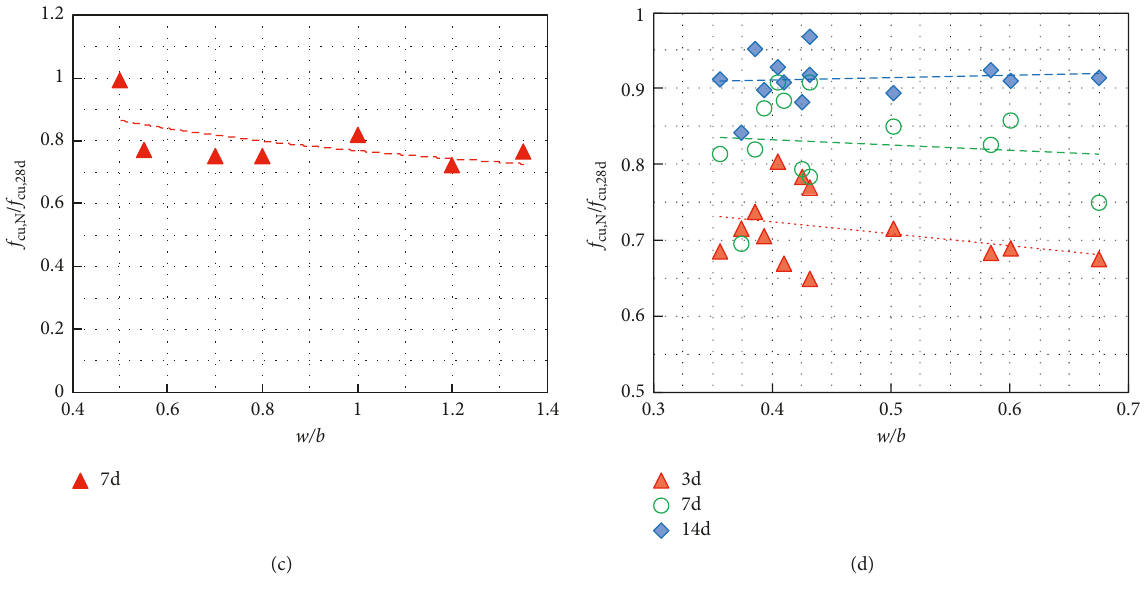
Figure 5: Effect of w/b on (f) cu,N /(f) cu,28d . (a) f cu,N /f cu, 28d versus w/b [28], (b) f cu,N / f cu,28d versus w/b [29], (c) f cu,N /f cu , 28d versus w/b [26], and (d) f cu,N / f cu,28d versus w/b in this